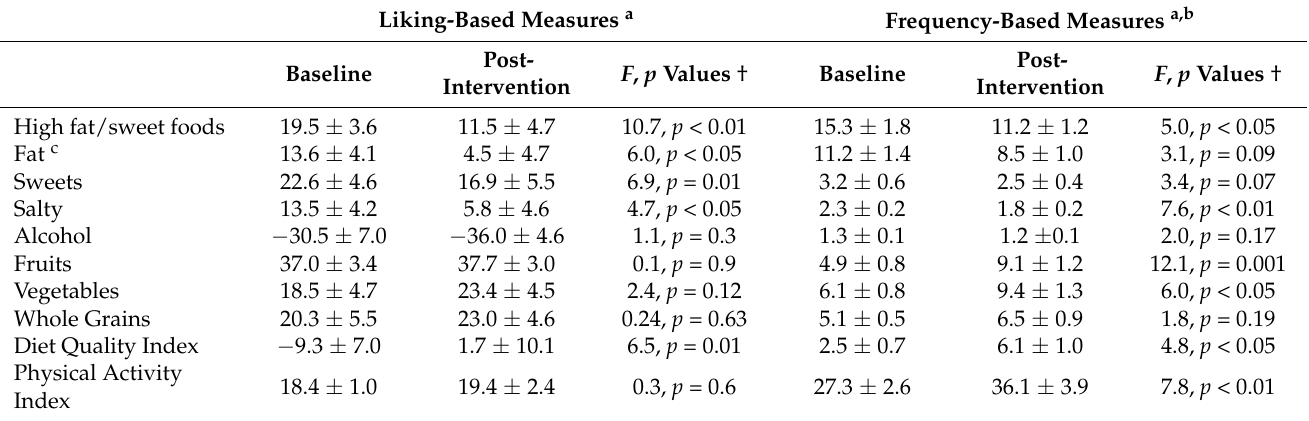
Table 3. Average ( ± S.E.) absolute values for the diet and physical activity variables at baseline and post-intervention. Liking-Based Measures